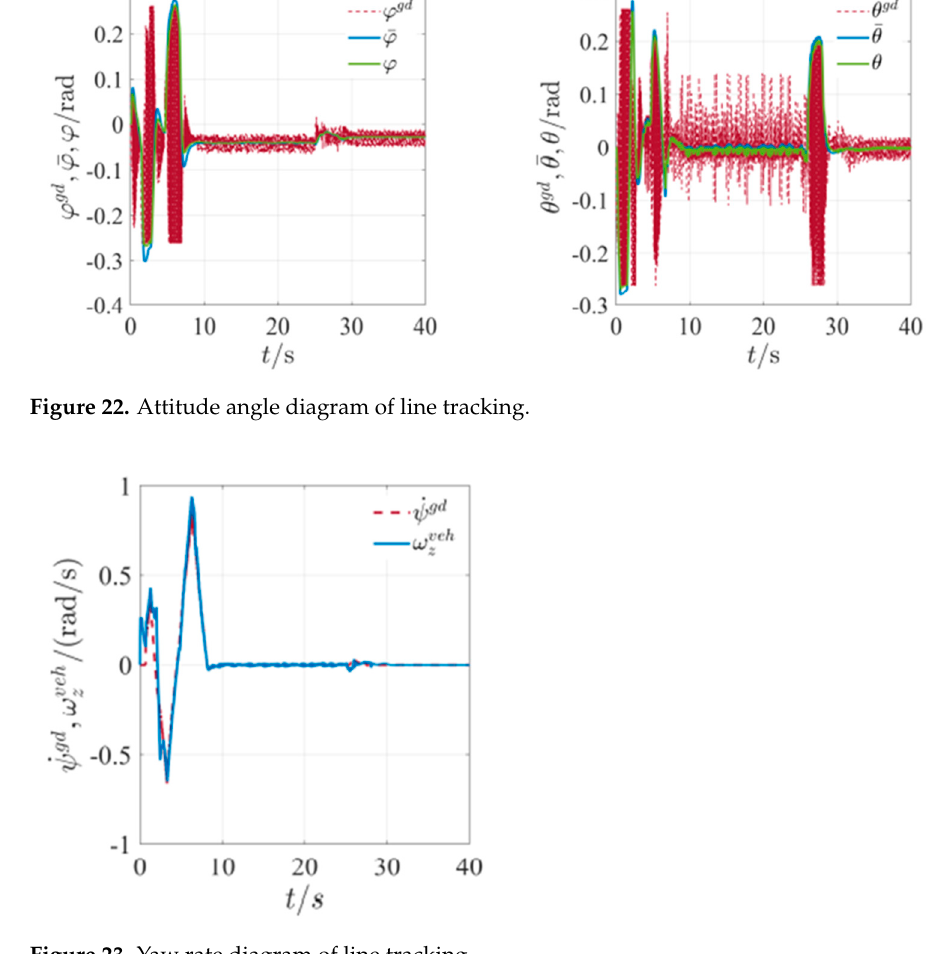
Figure 23. Yaw rate diagram of line tracking.